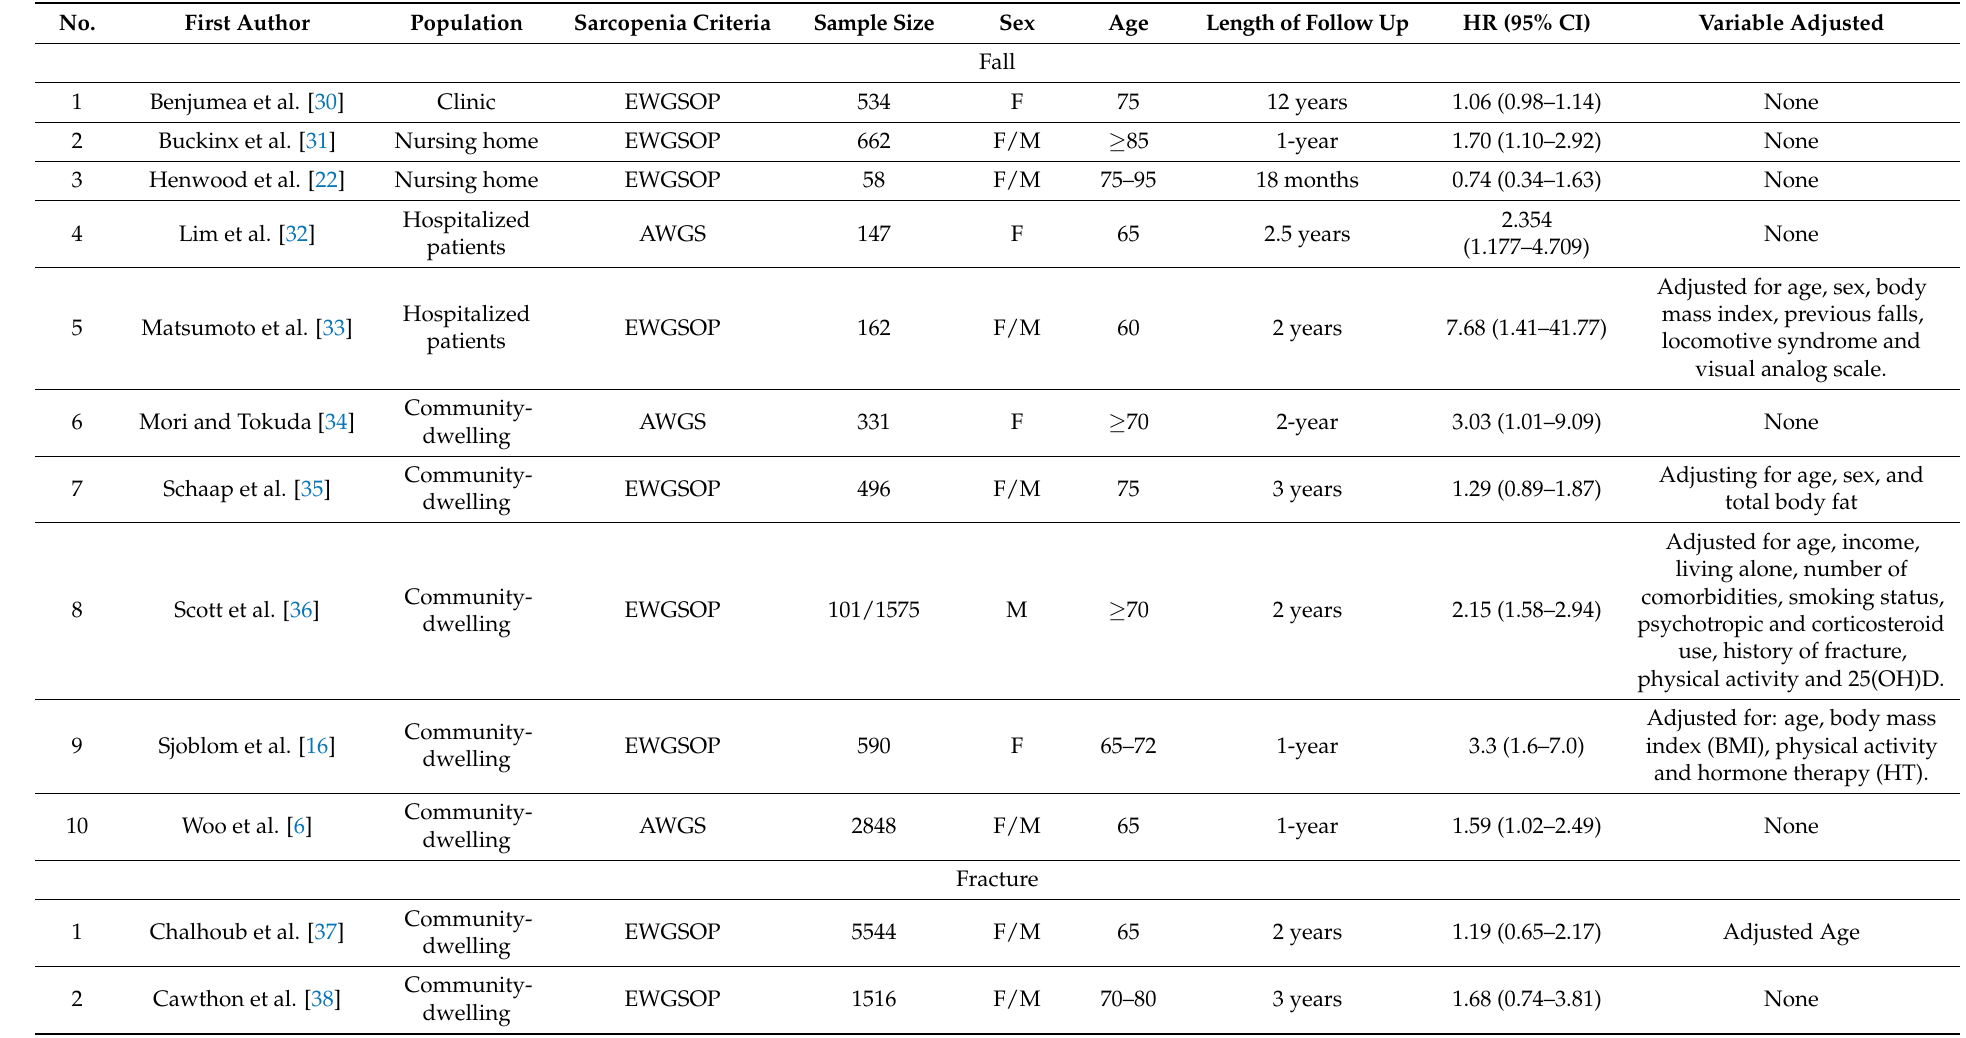
Table 1. Characteristics of the included studies for